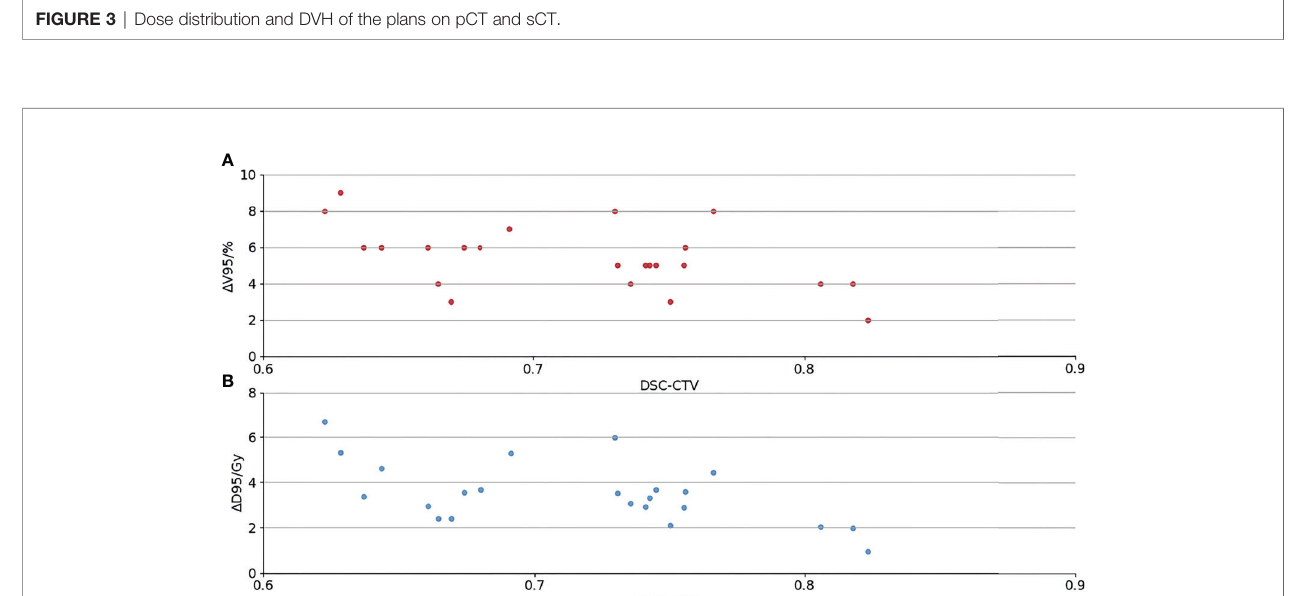
FIGURE 3 | Dose distribution and DVH of the plans on pCT and sCT.